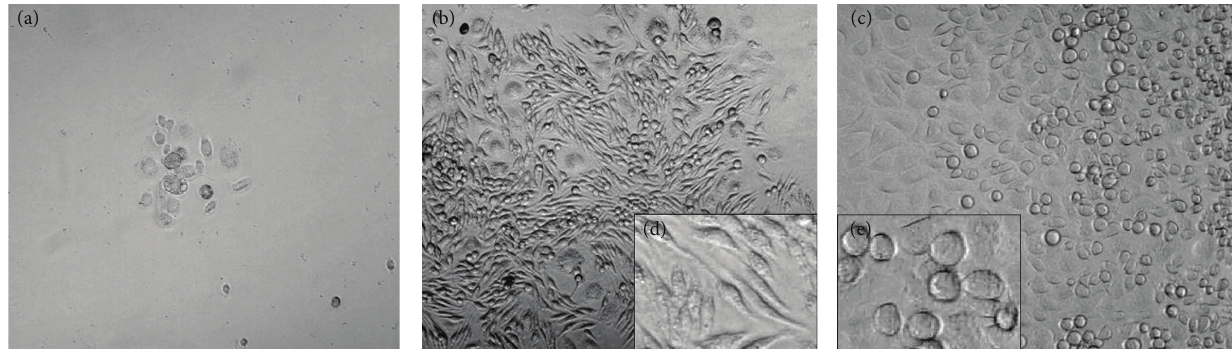
Figure 1: Effects of different culture media on the yield and the morphology of the cultured microglial cells. (a) Mixed retinal culture grown in DMEM showing low cell numbers. ((b) and (d)) Cells grown in DMEM/F12 + Glutamax showing a good yield and no change in the morphology was observed. ((c) and (e)) Some of the cells grown in RPMI/F12 + Glutamax started to change into more round-shaped cells. Microglial cells were observed after 15 days in culture using a phase-contrast Olympus microscope and Prog Res C14 imaging software. Magnification × 20; (d) and (e) are enlarged. Data are representative of 3 experimental repeats.